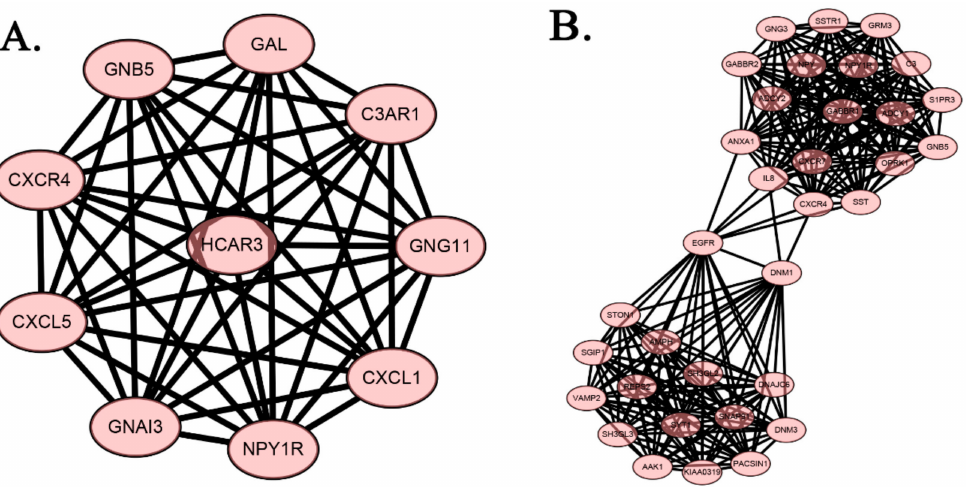
Figure 4. PPI of the core gene module. ( A ) The PPI of the most significant core module about MDD. ( B ) The PPI of the secondary core gene module about GBM. Node: protein; connection: the interaction between proteins. MDD, Major Depressive Disorder. GBM,